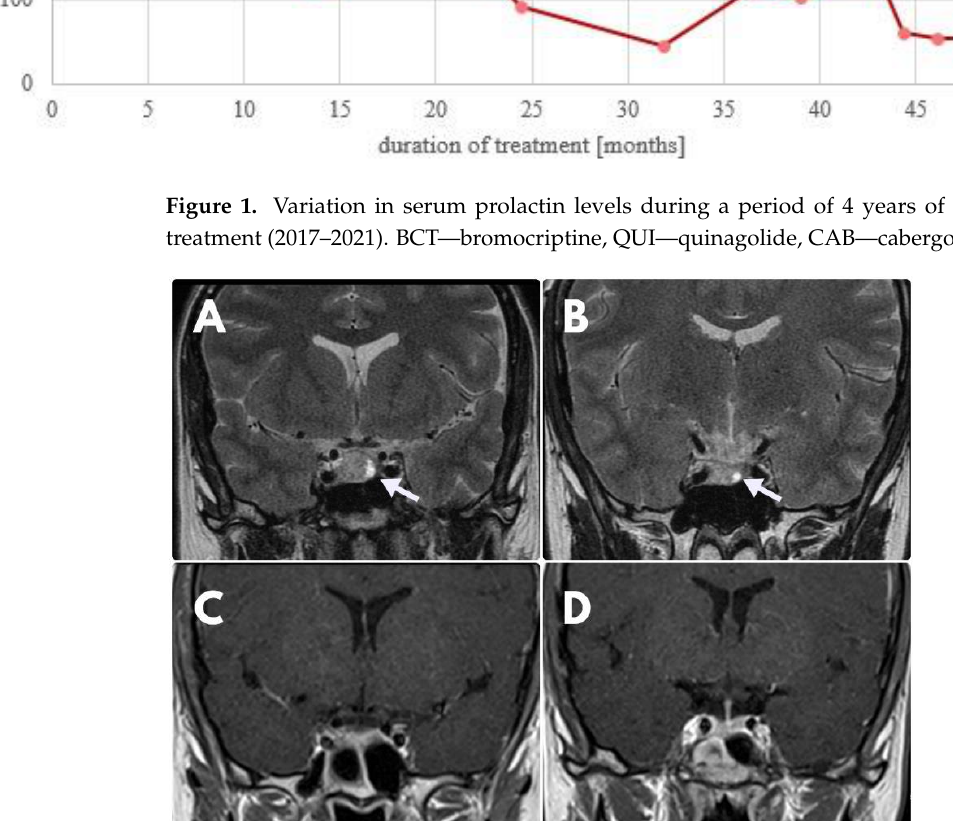
Figure 1. Variation in serum prolactin levels during a period of 4 years of dopamine agonists treat- ment (2017 – 2021). BCT — bromocriptine, QUI — quinagolide, CAB — cabergoline.